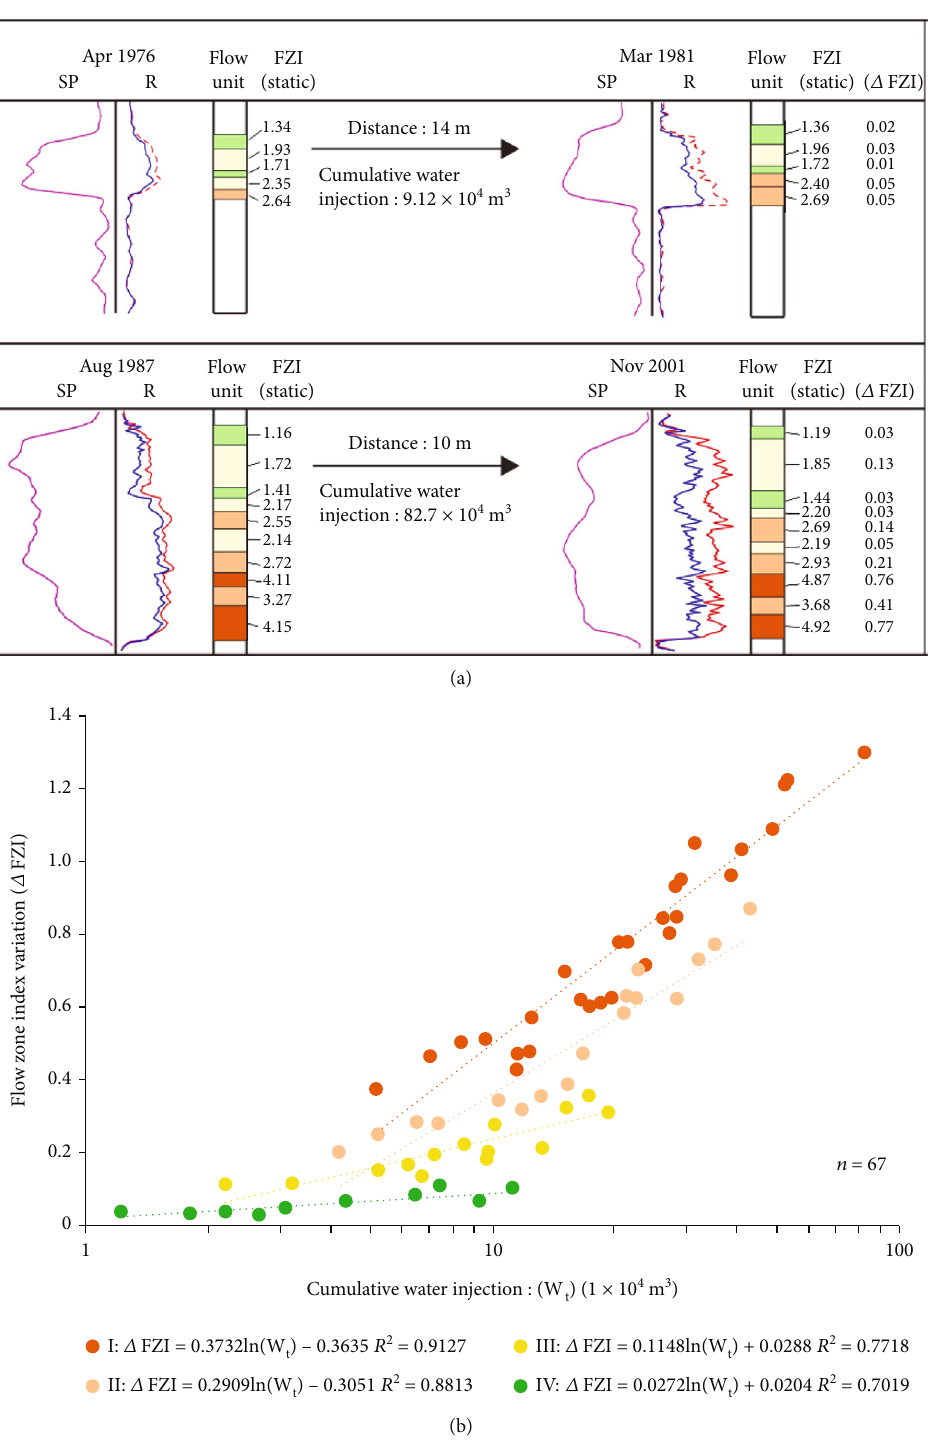
Figure 8: Relationship between cumulative water injection of subwells and FZI variation. (a) Flow unit characteristics of subwells. (b) Relationship between fl ow zone index change and cumulative water